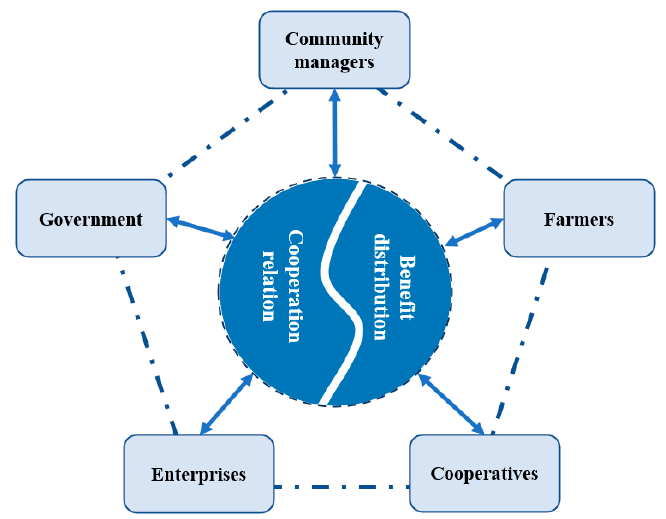
Figure 3. relationship among multiple stakeholders in IID. Figure 3. Relationship among multiple stakeholders in